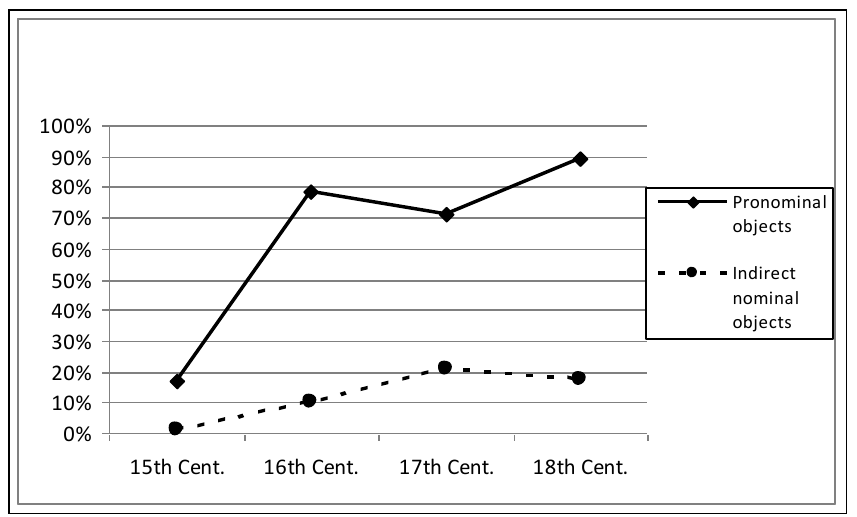
Figure 2 : Diachronic development of CD with pronominal and indirect nominal objects (Gabriel and Rinke